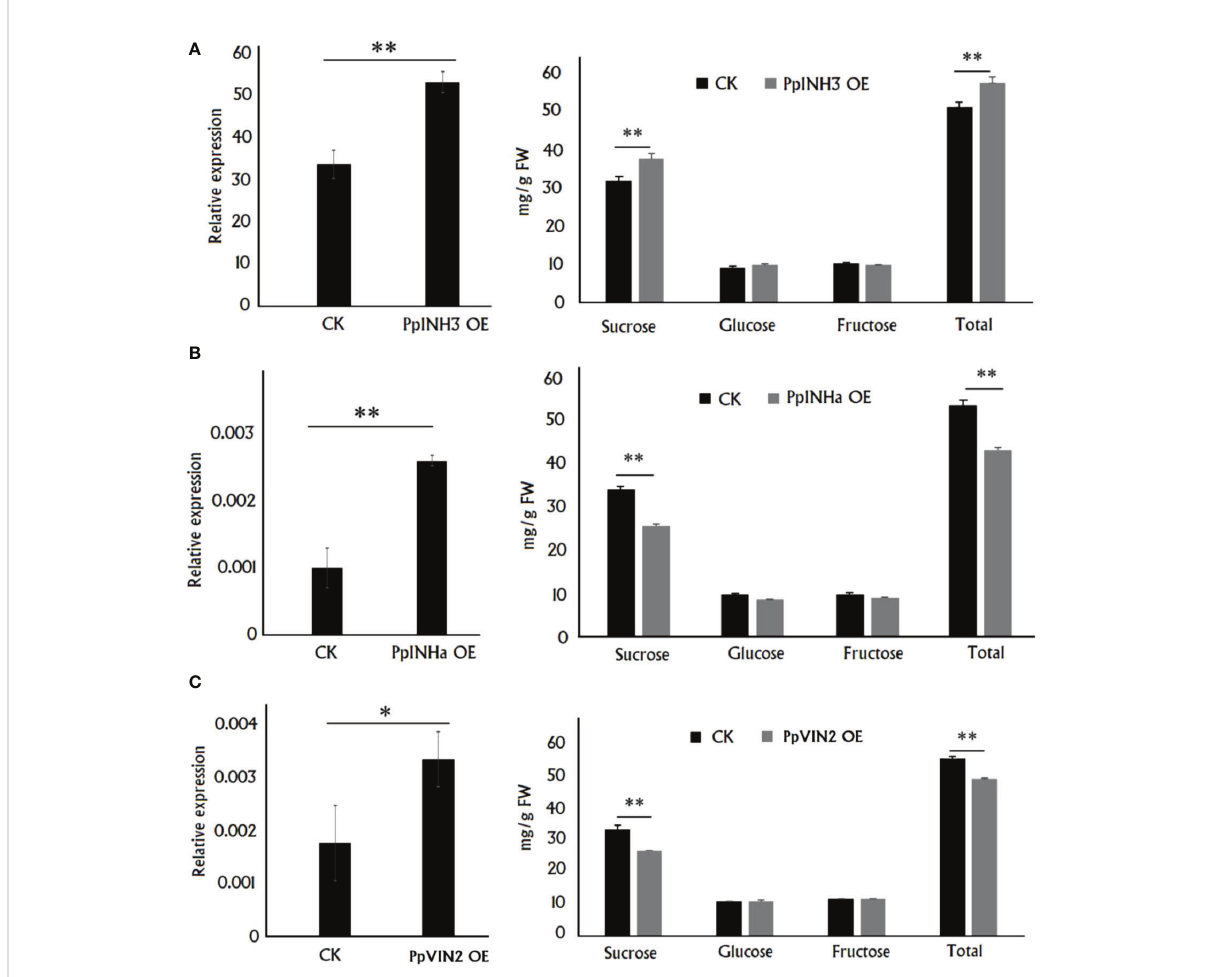
FIGURE 3 Functional analysis of PpINHs and PpVIN2 via their transient overexpression in peach fruits at the ripening stage. (A) , The PpINH3 expression and sugar accumulation in the fl eshy tissue surrounding the sites in fi ltrated with either PpINH3 or the empty vector (CK). (B) , The PpINHa expression and sugar accumulation in the fl eshy tissue surrounding the sites in fi ltrated with either PpINH3 or the empty vector. (C) , The PpVIN2 expression and sugar accumulation in the fl eshy tissue surrounding the sites in fi ltrated with either PpINH3 or the empty vector. ** and * indicate statistical signi fi cance at P < 0.01 and P < 0.05, respectively, based on Student ’ s t